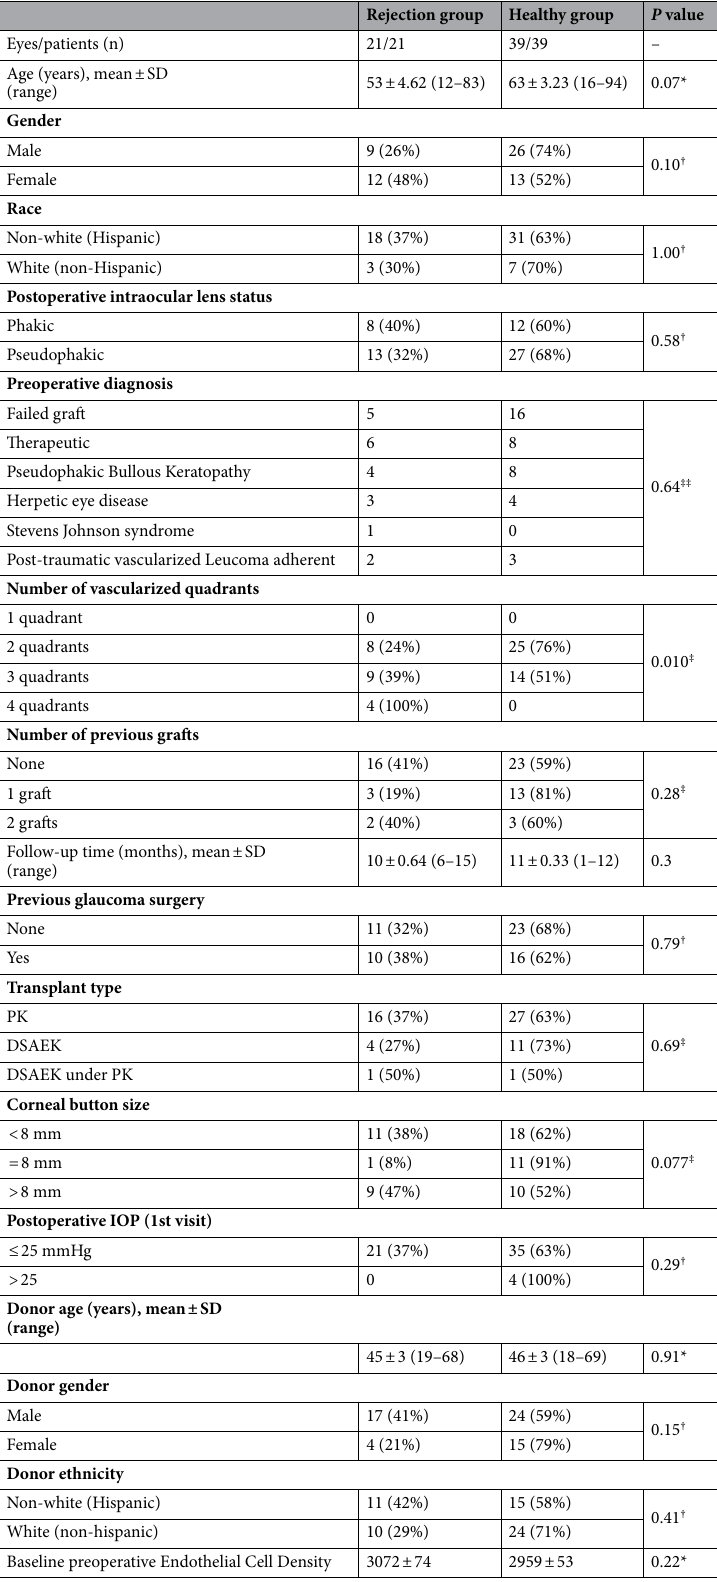
Table 1. Baseline recipient, donor and operative characteristics in the healthy grafts and the rejection grafts. *Two sample t-test. † Fisher exact test. ‡ Chi-squared test. ‡‡ Exact permutation